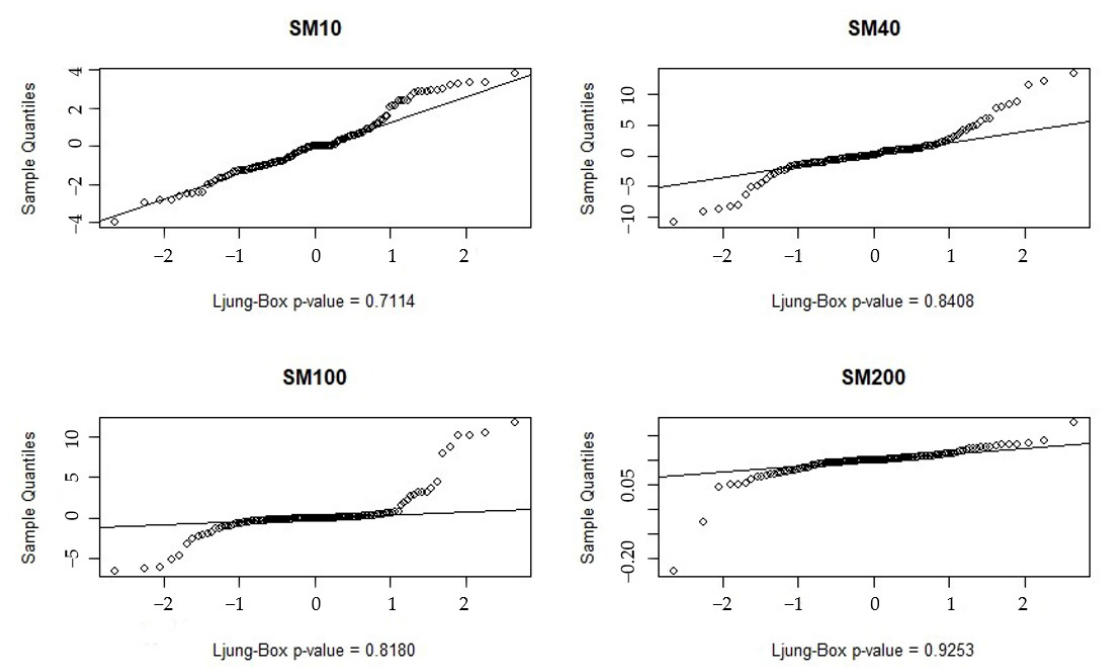
Figure 5. QQ plots of the predicted residuals of the seasonal ARIMA model at the different depths. Most of the residuals in Figure 5 closely follow the median trend line. The p -values of the Ljung–Box test are greater than 0.05, none of which rejects the original hypothesis (the Ljung–Box test is used to test the randomness of the time series). These indicate that the residuals meet the normality assumption and pass the white noise test, then the model can be considered to have adequately fitted the data and can be used in the next step of the forecasting process. The final predicted data were obtained, as shown in Table 7. Table 7. Predicted values of the soil moisture, based on the seasonal ARIMA